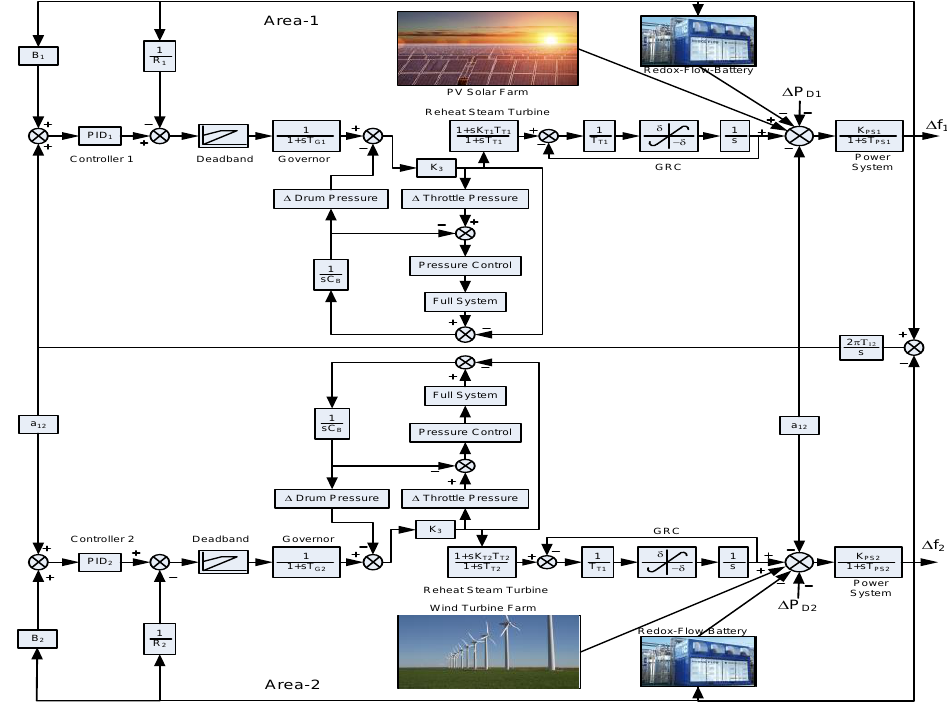
Figure 1. Transfer function model of the two-area power system.